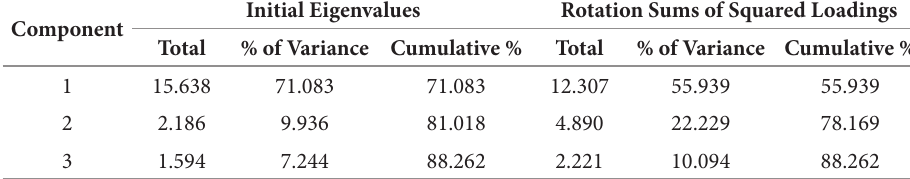
Table 3. Total Variance explained Initial Eigenvalues Rotation Sums of Squared Loadings Component Total % of Variance Cumulative % Total % of Variance Cumulative